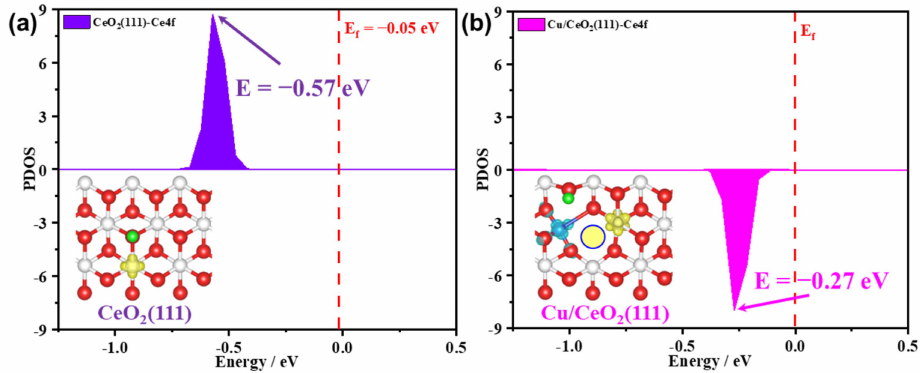
Figure 4. Calculated partial density of states (PDOS) of the Ce 3+ on the ( a ) CeO 2 (111) and ( b ) Cu/CeO 2 (111) surfaces with one H being adsorbed on O. The Fermi energy level (E f ) is la- beled with a red dashed line. All DOS are aligned with respect to the O 2 s orbital of a fixed bottom O atom of the surface